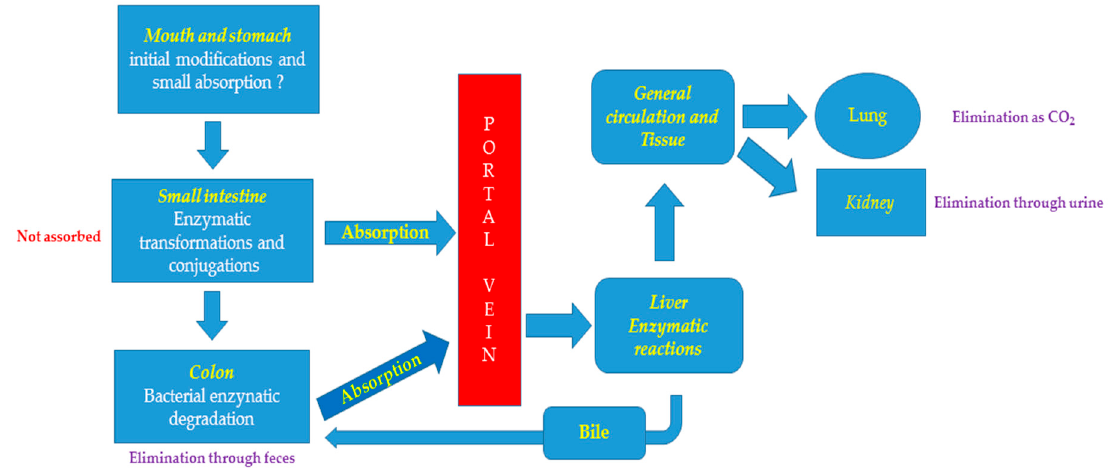
Figure 2. Schematic predicted routes for absorption and elimination of dietary